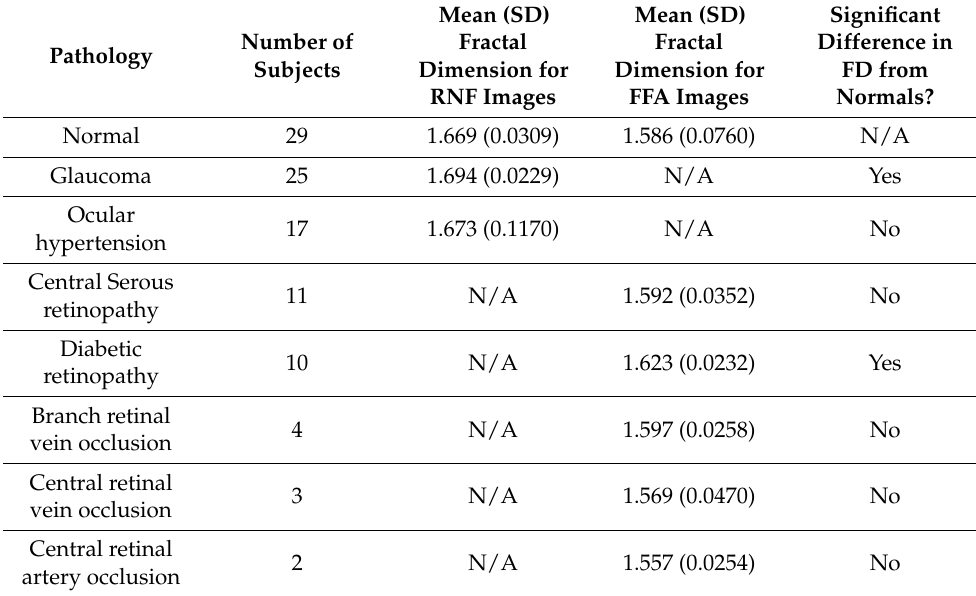
Table 1. Outcomes of fractal analysis on patients as reported by